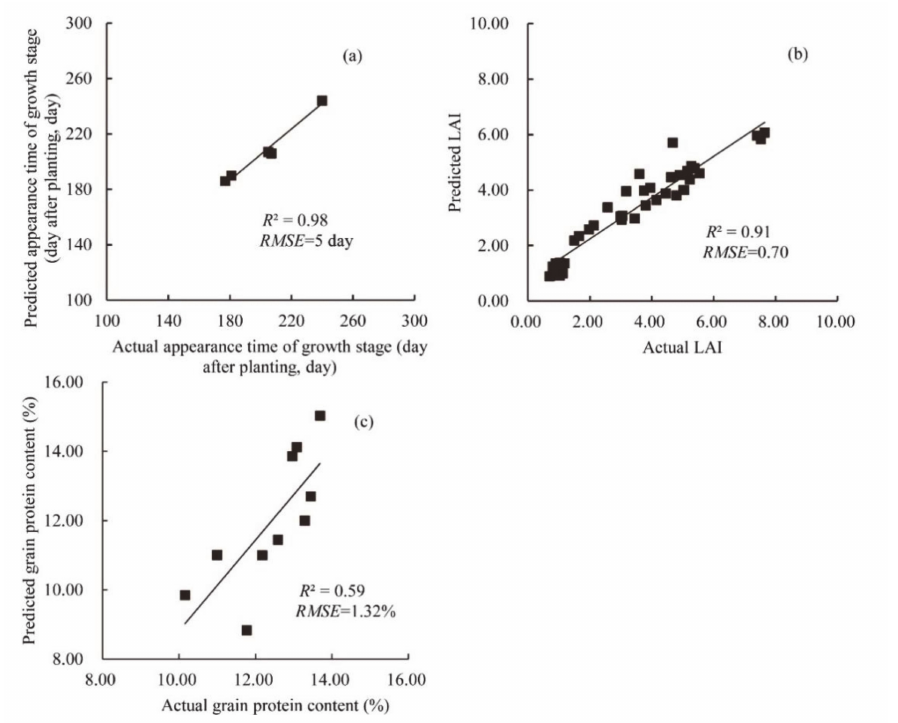
Figure 3. Calibration results for the CERES-Wheat model. ( a ) Appearance time of growth stage; ( b ) leaf are index (LAI); and ( c ) grain protein content